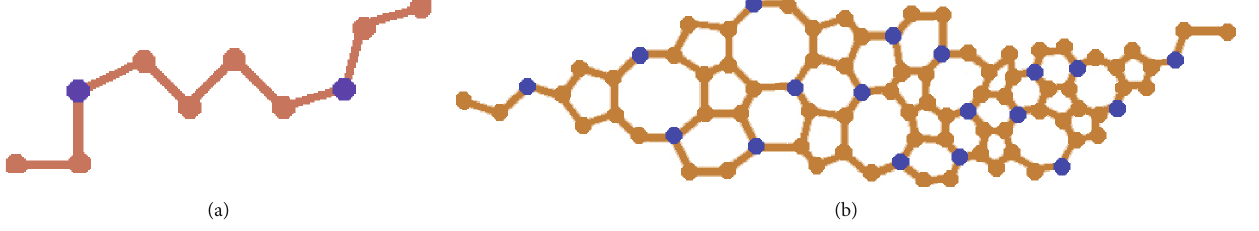
– II [i, j] and (b) SiC 4